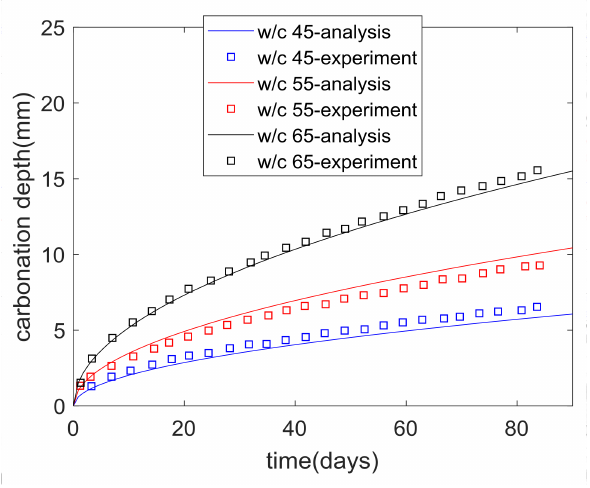
Figure 3. Carbonation depth of sound